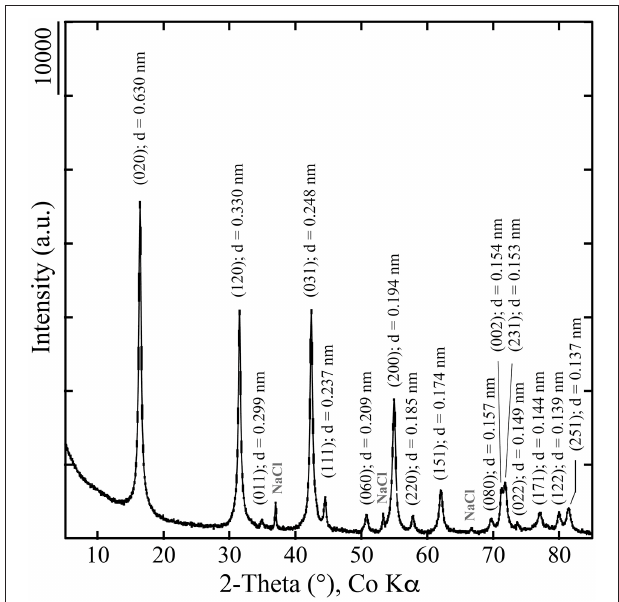
FIGURE 2 | X-ray diffractogram of the lepidocrocite sample.